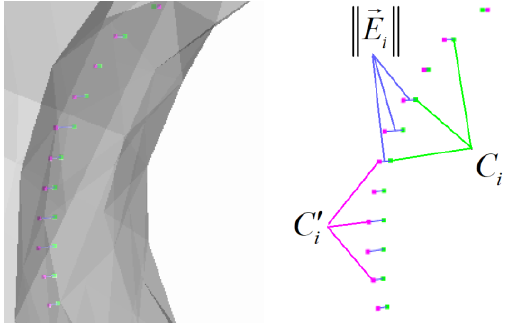
Figure 5. Trajectories projected onto the surfaces of the object (red) and its model (green).